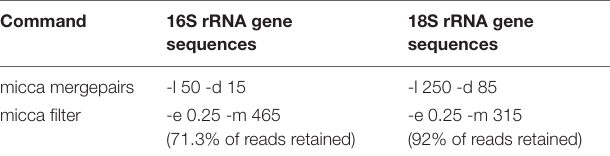
TABLE 2 | Data processing parameters for 16S rRNA and 18S rRNA gene sequences (implemented in micca v. 1.6.2; https://compmetagen.github.io/